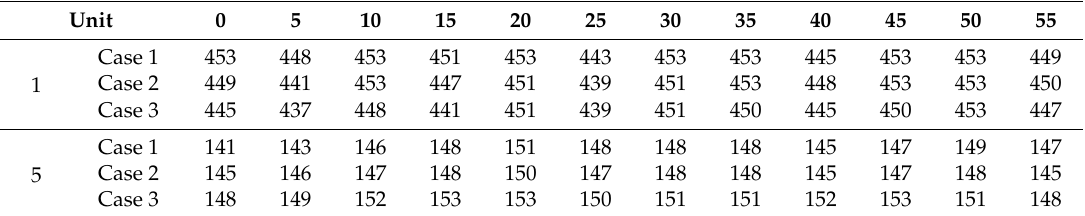
Table 6. Real-time economic dispatch schedules at hour 20.